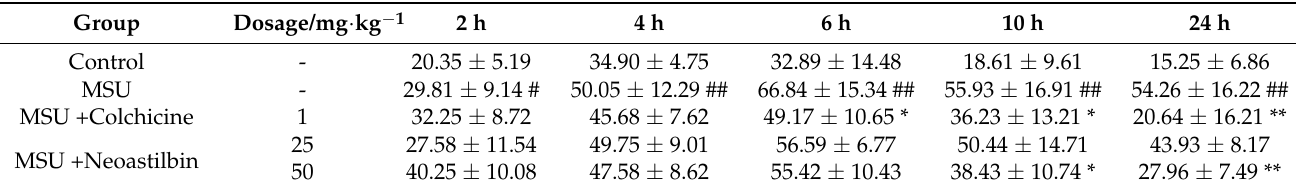
Table 1. Measurement of the ankle joint swelling in